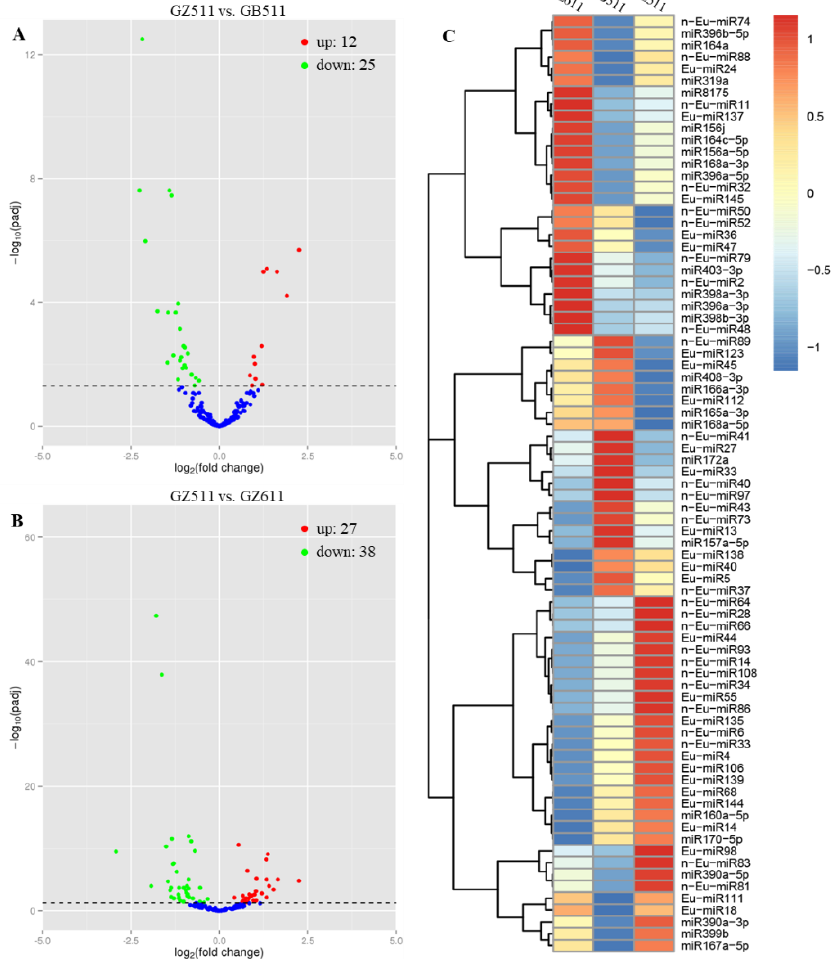
Figure 2. Volcano plots of up − and downregulated miRNAs in the comparisons of GZ511 vs. GB511 ( A ) and GZ511 vs. GZ611 ( B ), and heatmap of DE − miRNAs drawn based on Z − scores of log 10 (TPM) ( C ).